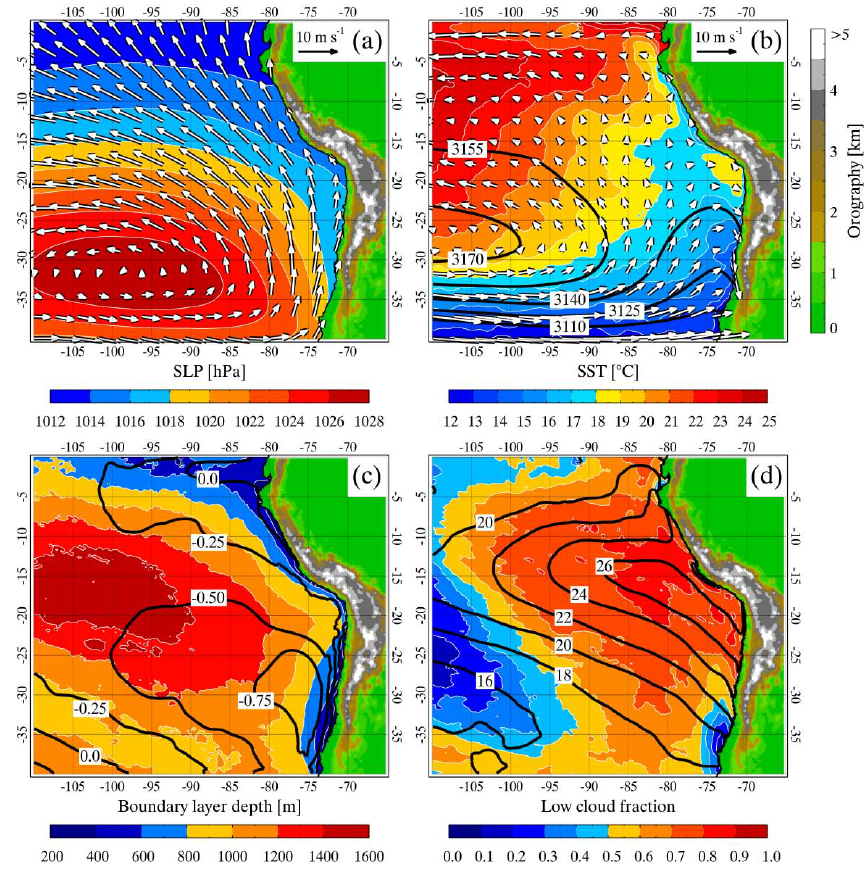
Fig. 1. Mean model fields for the period 14 October to 19 November 2008. The model orography is shown over land. (a) SLP (colours, hPa) with 10 metre wind arrows. (b) SST (colours, ◦ C) with 700hPa geopotential height (contours, m) and 700hPa wind arrows. (c) Boundary layer depth (colours, m) with 700hPa vertical velocity with a 4 degree latitude and longitude smoothing window applied (contours,cms − 1 ). (d) Low cloud fraction (colours) with lower tropospheric stability (contours, ◦